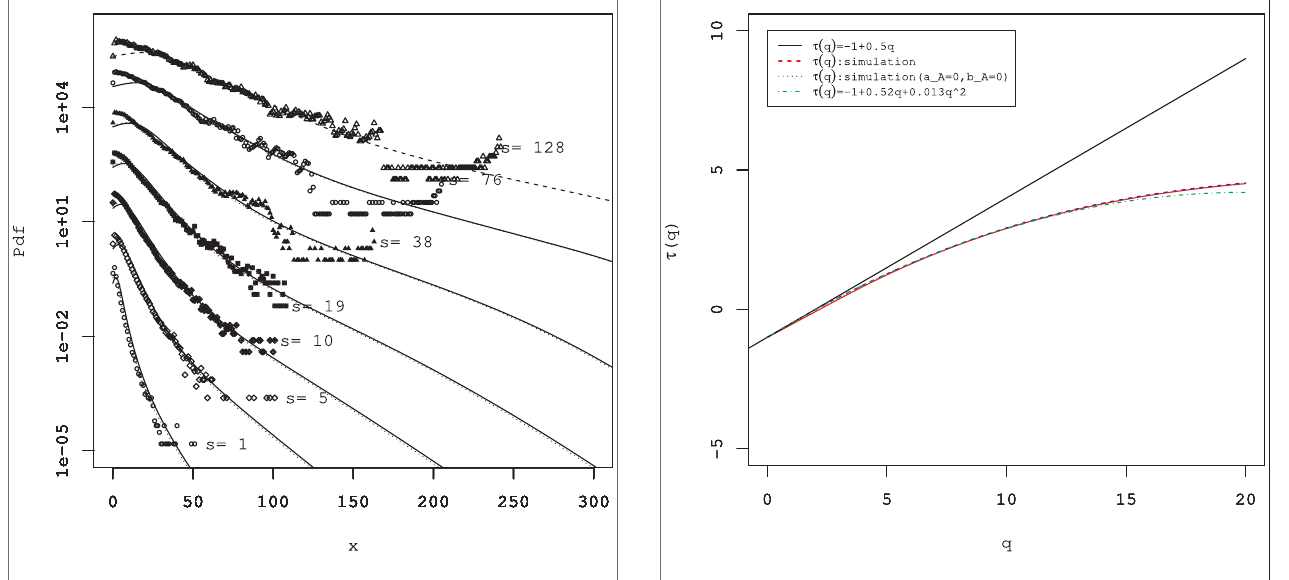
FIGURE 11 | Scaling exponent τ ( q ) . A representation of each line is shown in the legend.